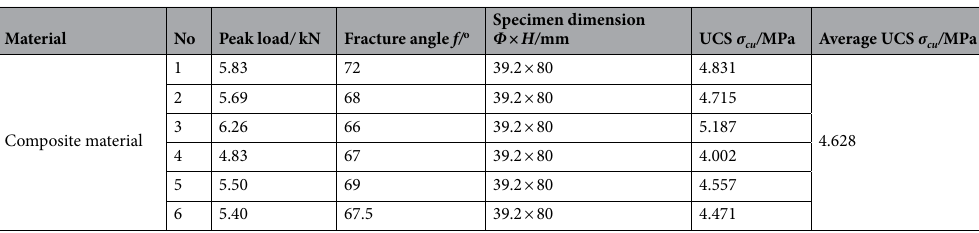
Table 1. Results of Uniaxial compression